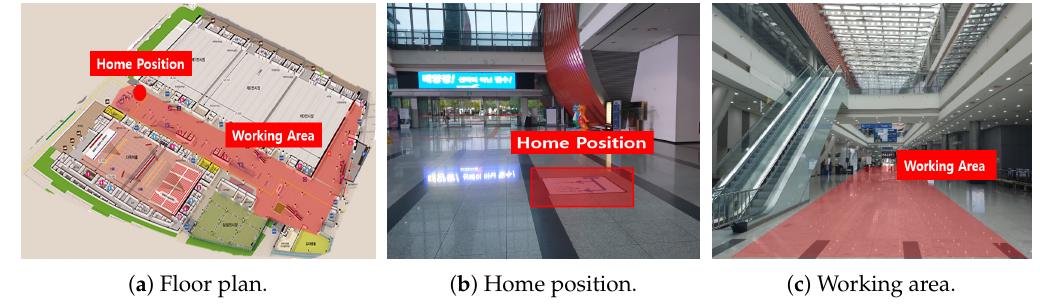
Figure 10. Experimental